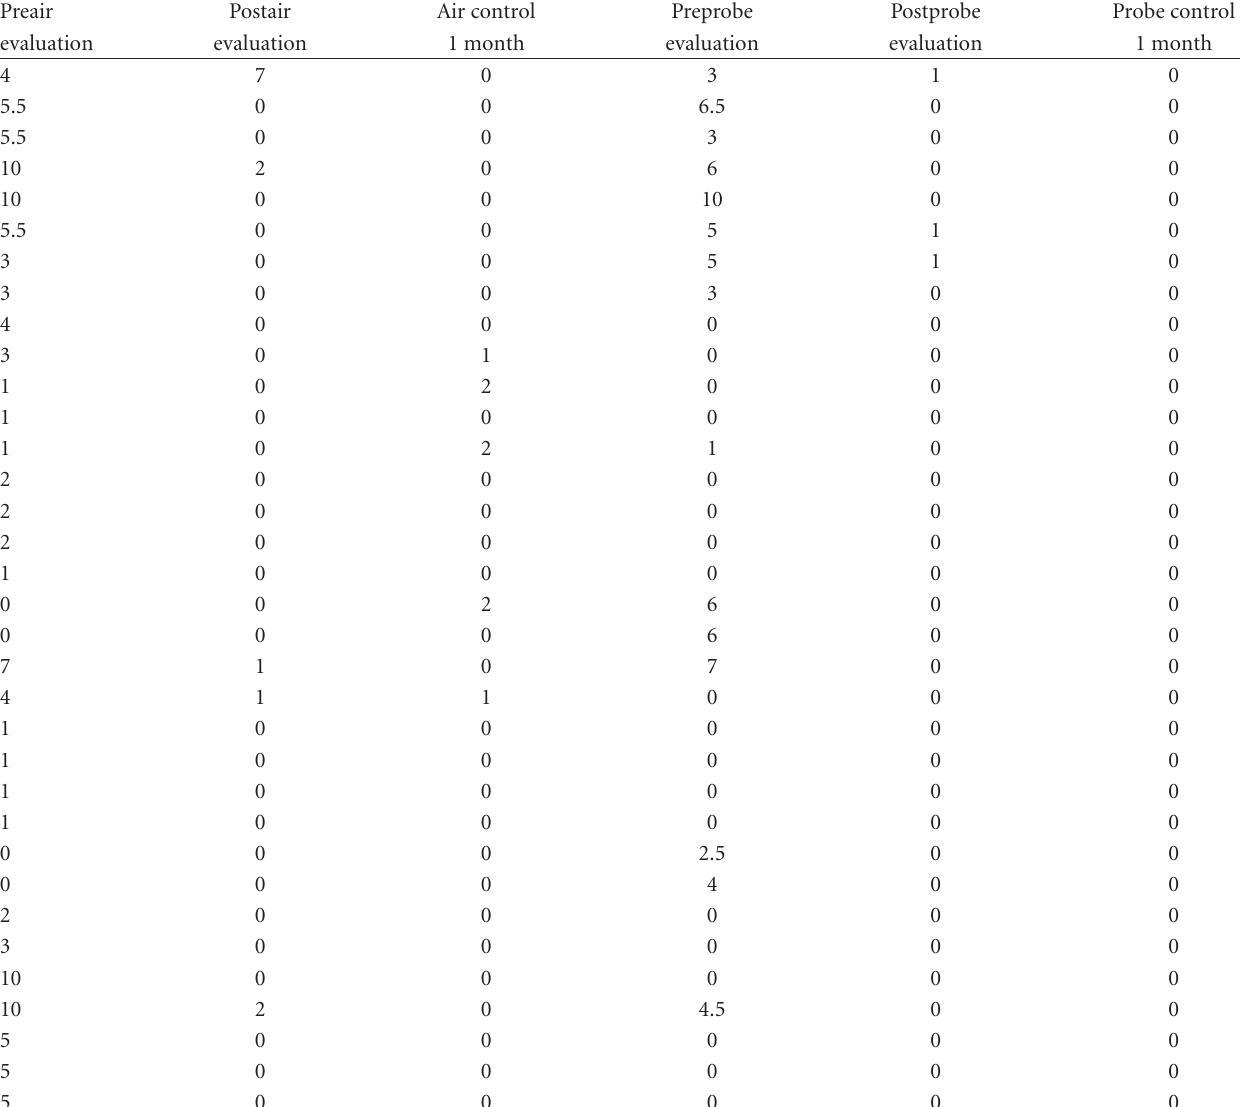
Table 1: Chart of NRS pretreatment, posttreatment, and at 1-month control values of the G1 (only NaF